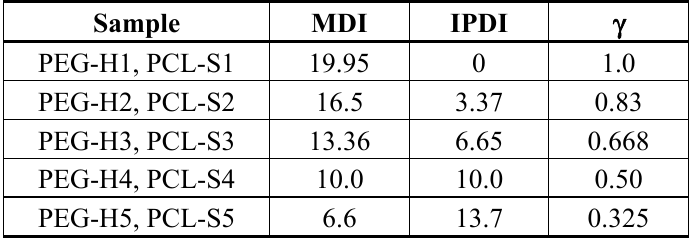
Table 1. Molar ratio of diisocyanates used for synthesis of shape memory